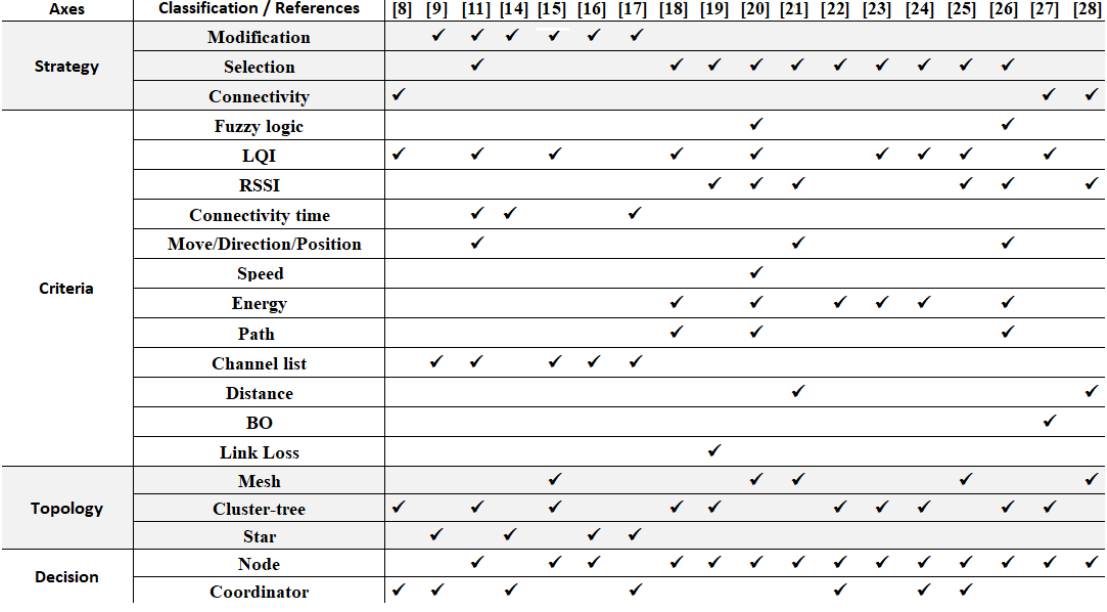
Figure 2. Synthesis of the reported